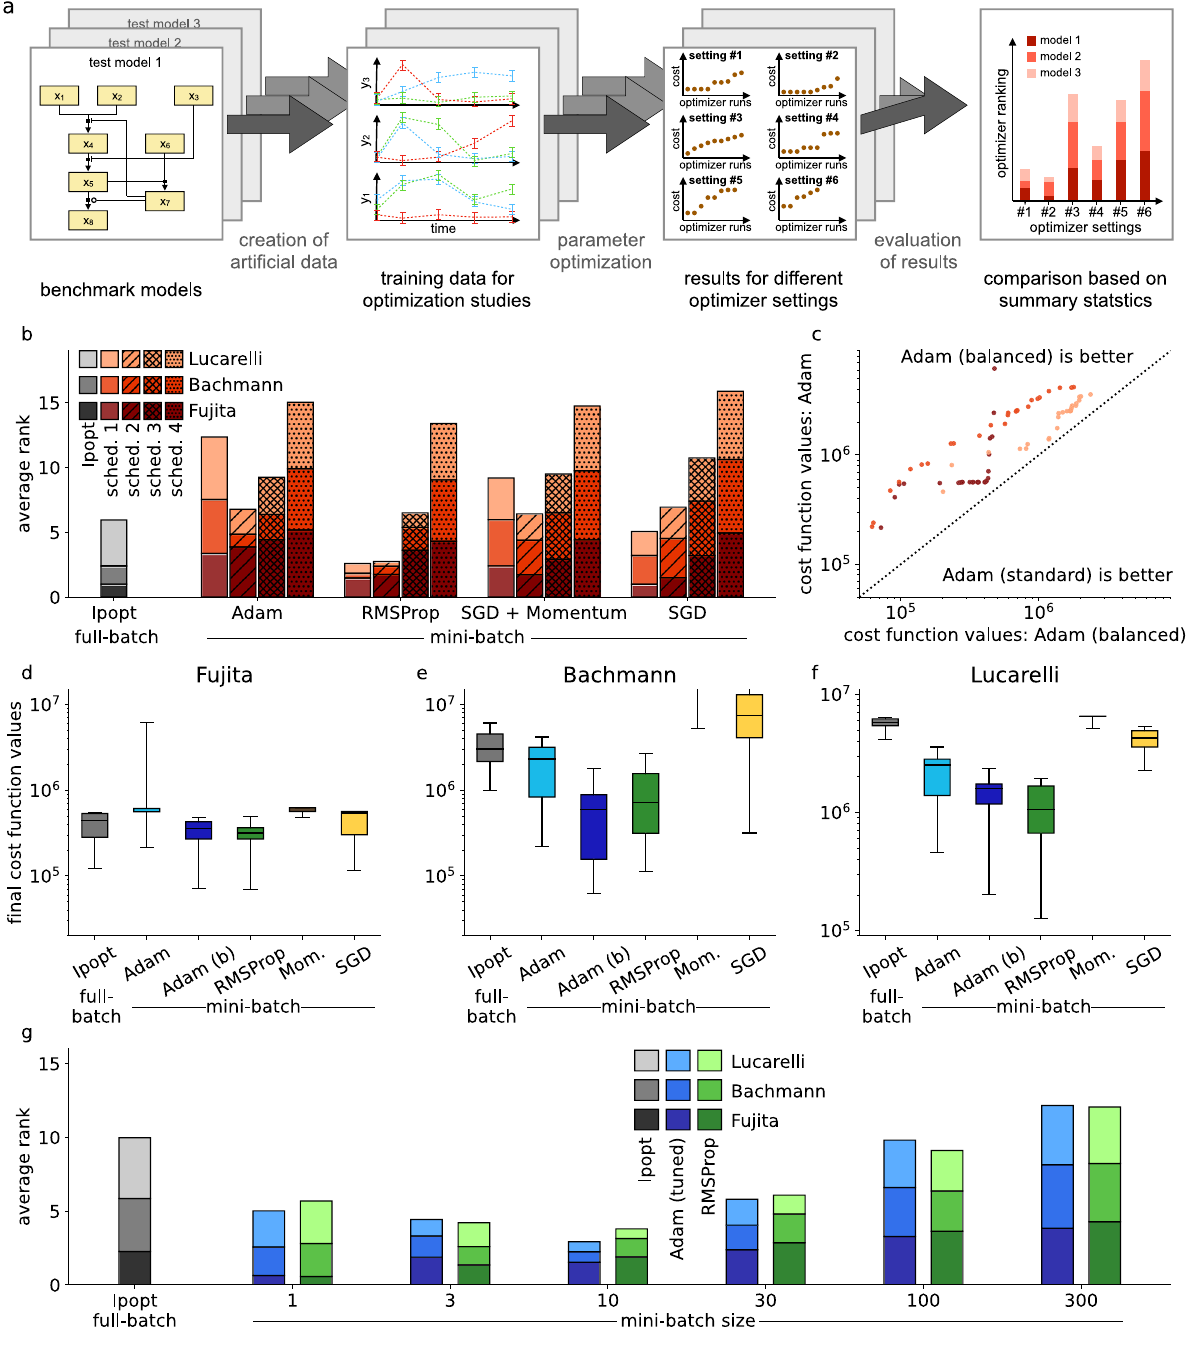
Fig. 2 Benchmarking full-batch vs. mini-batch optimizers on small- to medium-scale models. a Overview of optimizer comparison: Benchmark models were simulated, noisy arti fi cial data created, 100 initial points were randomly sampled, and different local optimizers started, each start was ranked between optimizers, and an averaged score was computed. b Comparison of performance for different local optimizers with different learning rate schedules (lower rank implies better performance, ranks averaged over models). c Top 25 starts of the local optimizer Adam with tuning parameters taken from the literature (standard) vs. a simpli fi ed version (balanced). d – f Boxplots of fi nal cost function values for the best 25 starts of the investigated mini- batch optimizers including the balanced version of Adam, denoted as Adam (b), compared against the Ipopt (full-batch optimizer), for each model. Bold lines indicate medians, boxes extend from 25th to 75th percentiles, whiskers show the ranges of the data. g Comparison of all starts of the best two mini- batch optimizers given the learning rate Schedule 2, for different mini-batch sizes, compared against Ipopt (ranks averaged over